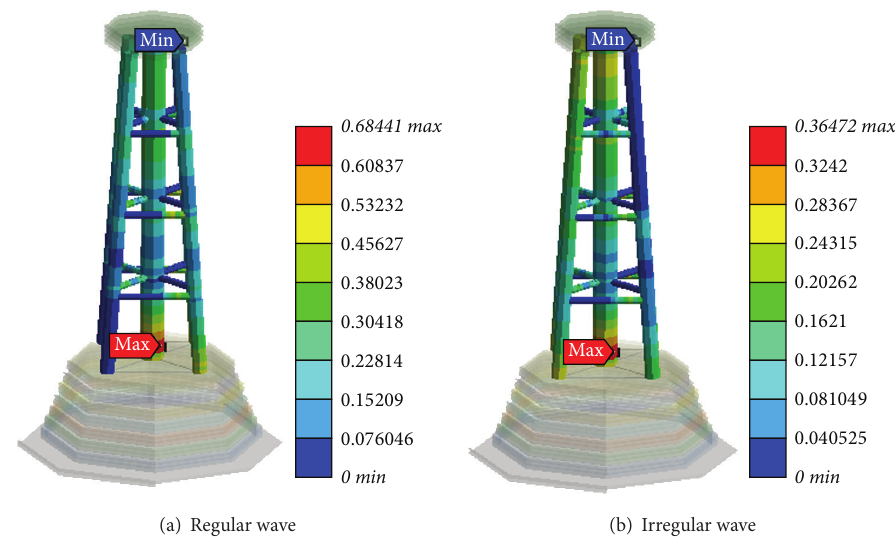
Figure 16: Member unity checks for yield 2 at